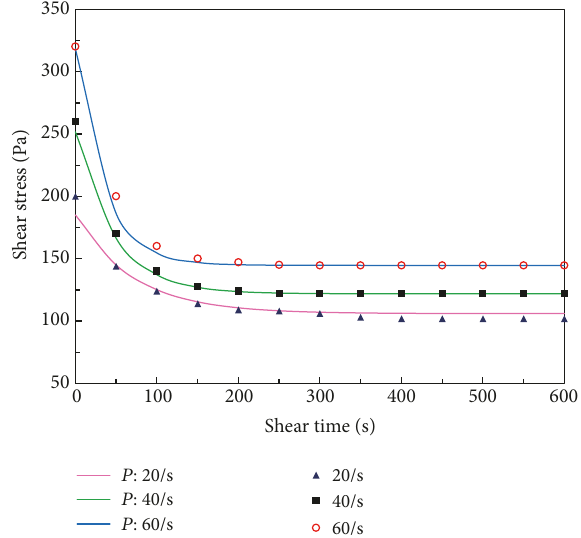
Figure 5: Comparison of the calculated shear stress and the tested